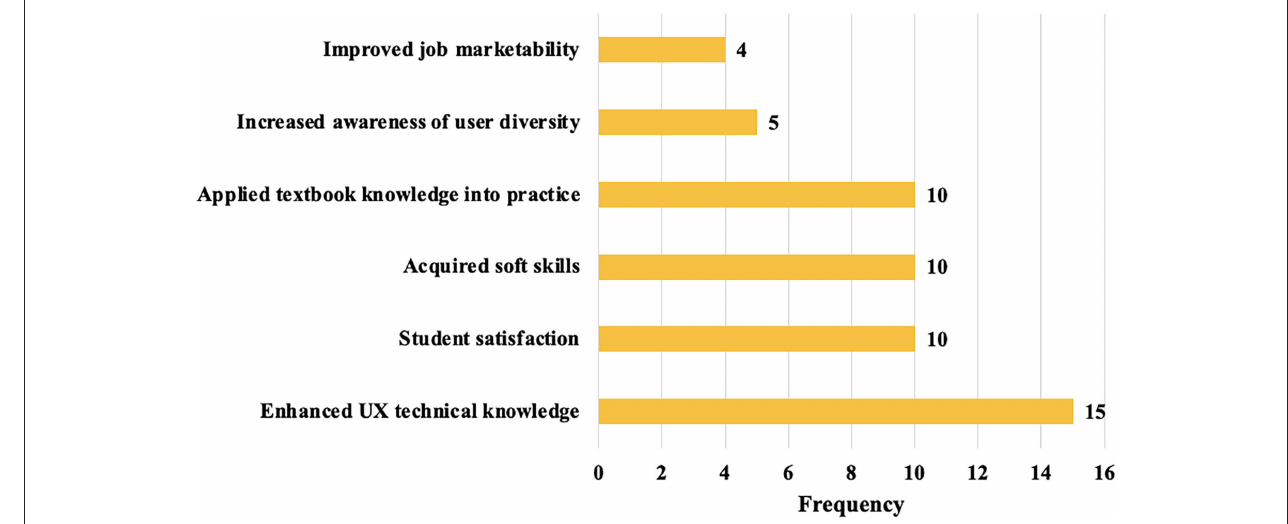
FIGURE 3 | A list of student learning outcomes and benefits from participating in EL.